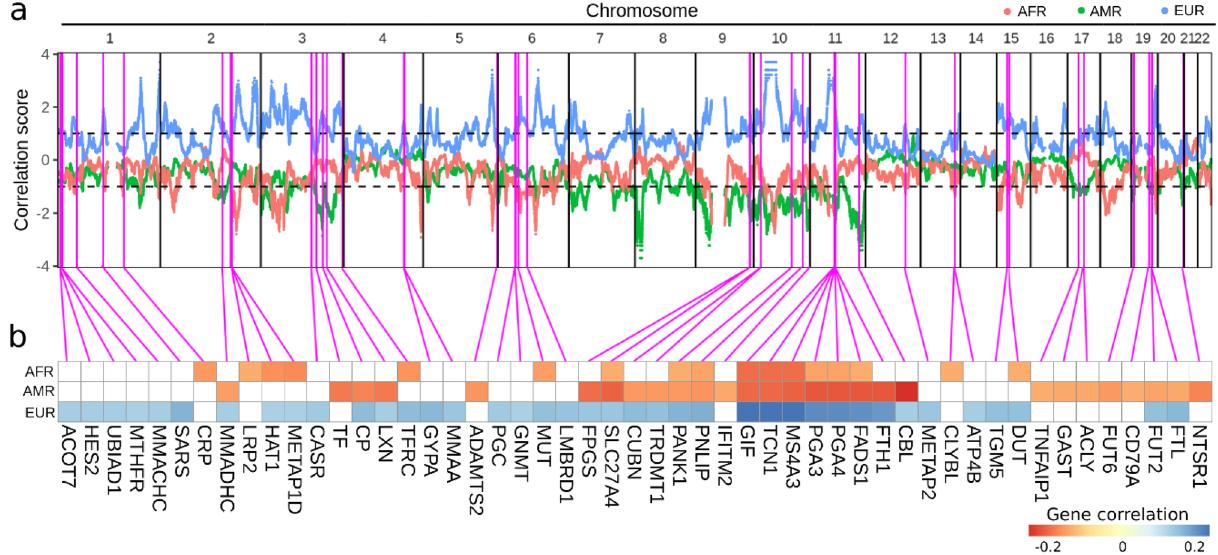
Figure 1. Ancestry results of three-way admixture AFR, AMR, and EUR. Mean local ancestry for individuals alongside autosomal chromosomes ( a ). Results of 10,000 permutations per each correlation between three-way local ancestry for ( b ) genes in Table 1 and vitamin B12 baseline levels. The position of the gene is designated by the vertical line (magenta). White cells indicate no significant correlation at p perm <